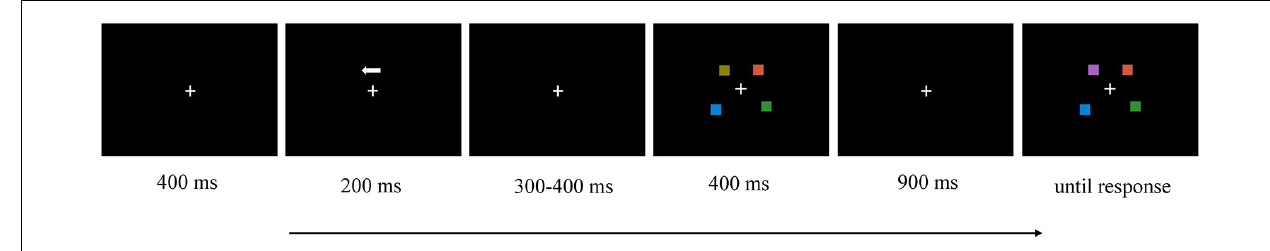
FIGURE 1 | Illustration of the time course of a trial in this experiment (e.g., left hemifield, two memory items, change).